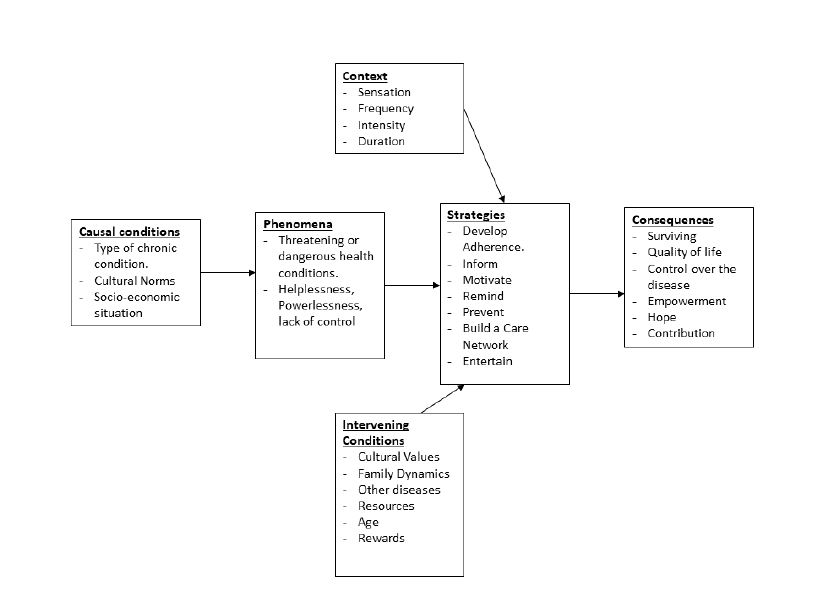
Figure 1. Axial Coding for the elements leading towards an innovative